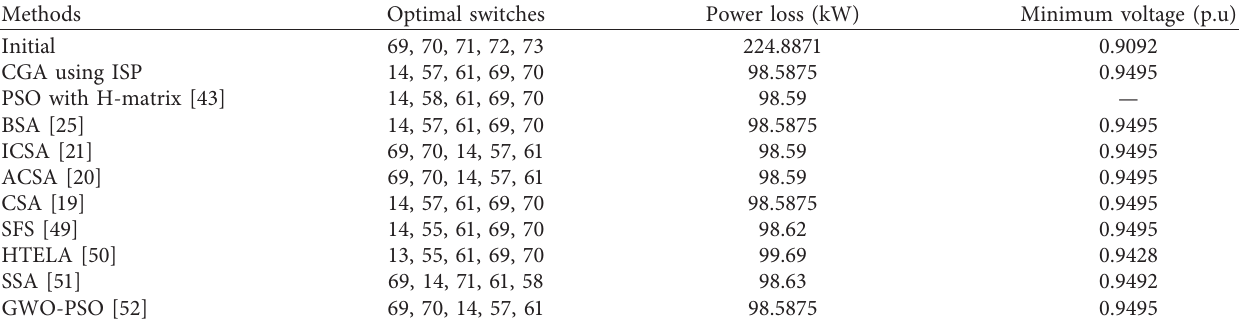
Table 6: Comparison results among the proposed method CGA using ISP with other methods for the 69-node system. Methods Optimal switches